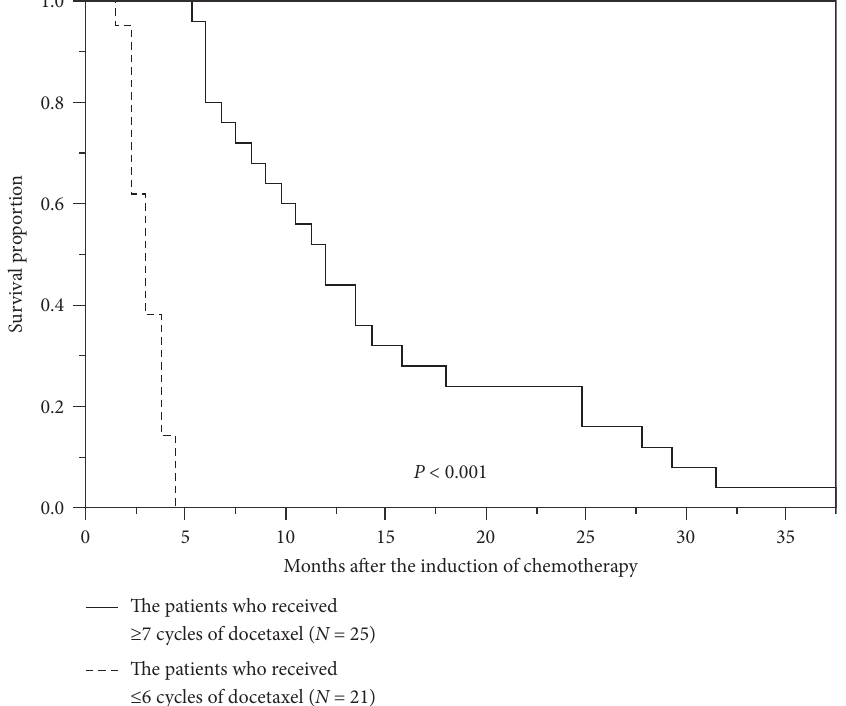
Figure 3: Kaplan–Meier estimate of progression-free survival (PFS). The median PFS in patients with prostate cancer who received ≥ 7 cycles of docetaxel (DOC) followed by cabazitaxel (CBZ) was significantly longer than that in patients who received ≤ 6 cycles of DOC followed by CBZ ( P < 0 . 001 )